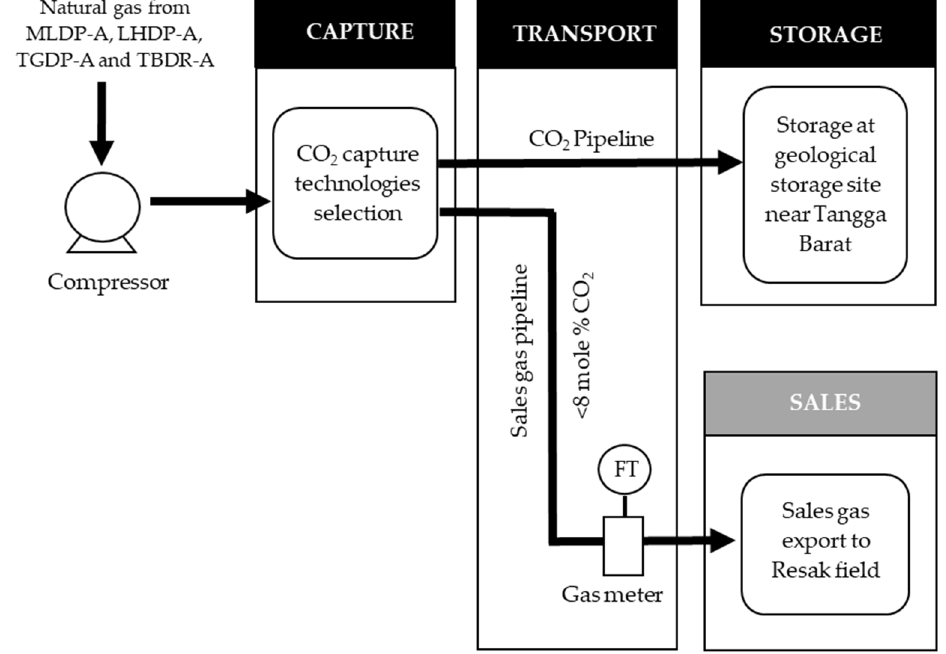
Figure 4. Carbon capture and storage (CCS) concept at Tangga Barat gas field.